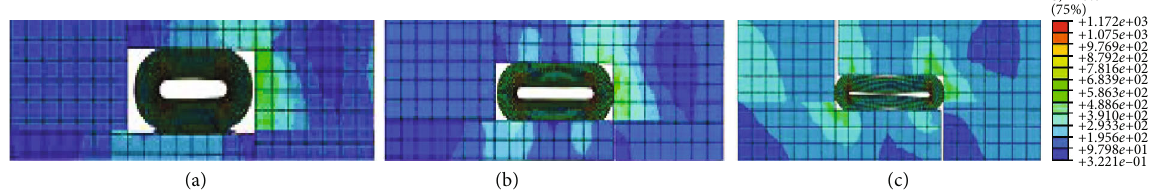
Figure 7: Compression of metal tubes of di ff erent wall thicknesses (distribution cloud picture of equivalent